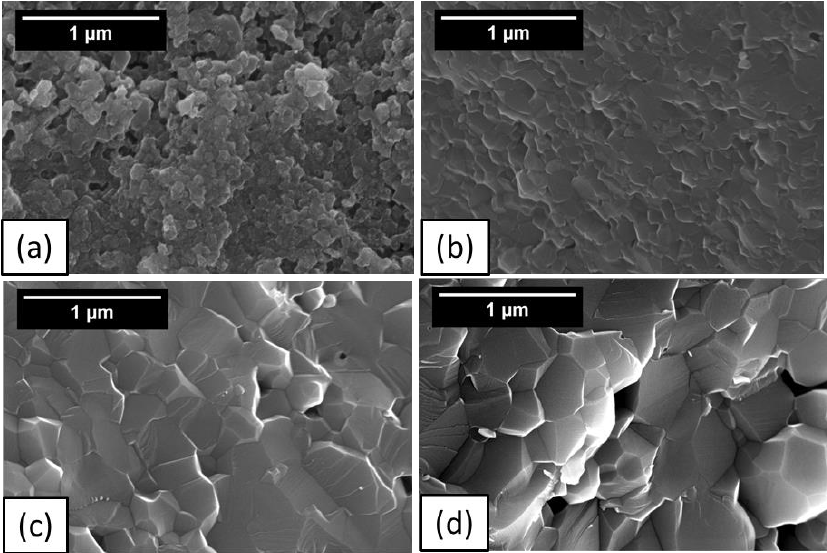
Figure 6. SEM micrographs of fractured surfaces of AlN bulk sample densified at ( a ) 1200 °C, ( b ) 1300 °C, ( c ) 1500 °C and ( d ) 1600 °C.